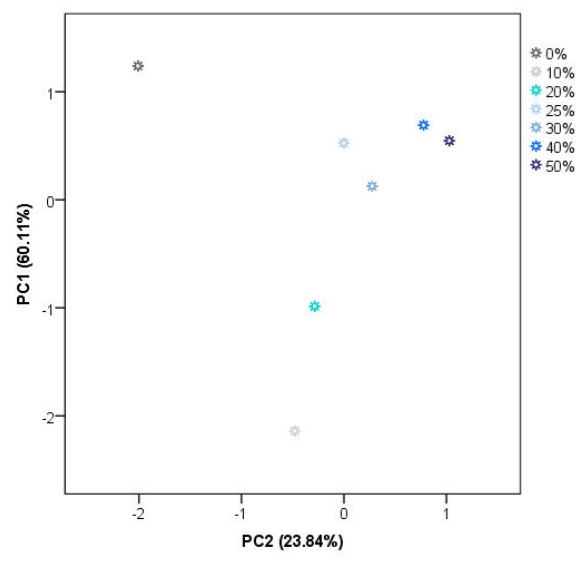
Figure 5. Two-dimensional PCA centroids plot (scores average for PC1 vs